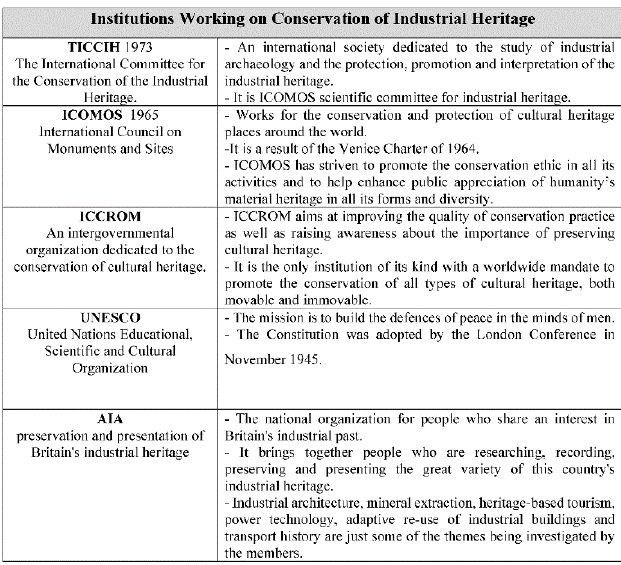
Table 1. Institutions Working on Conservation of Industrial Heritage (Developed by